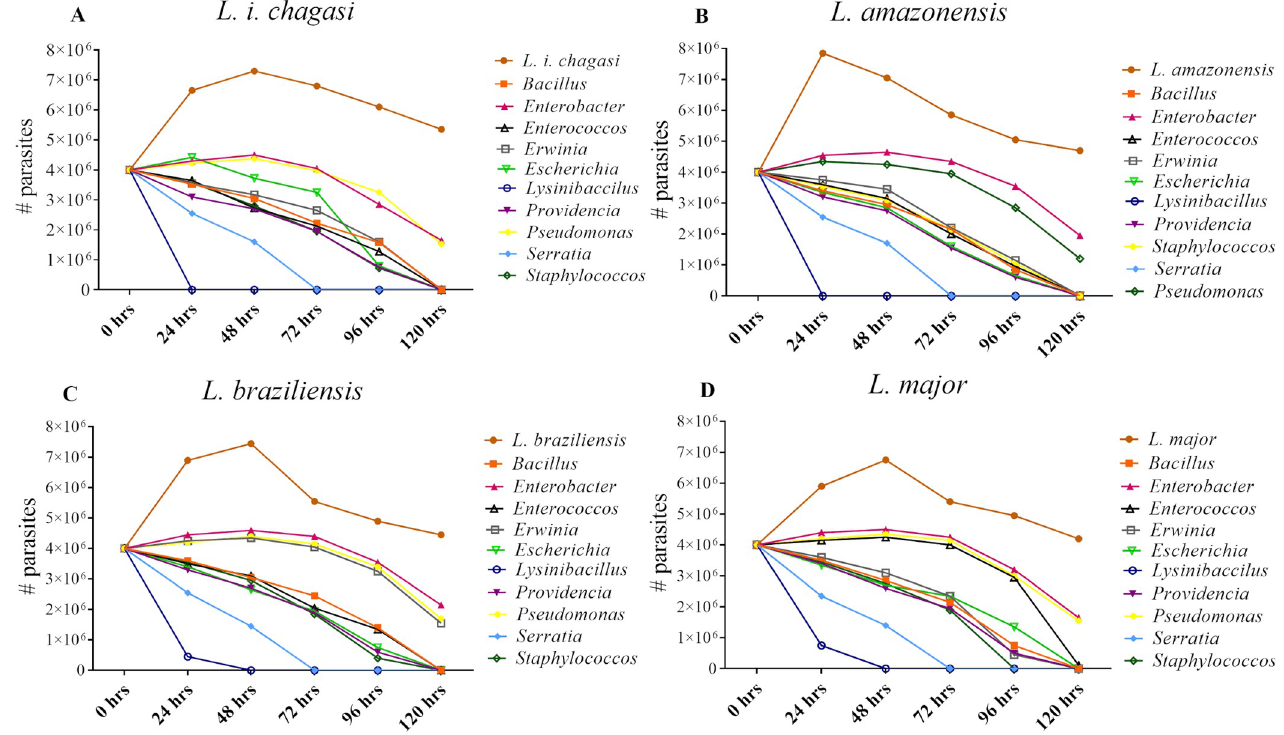
Fig 2. The long term mortality of Leishmania species when co-cultured with native bacteria. Over a 120 hrs. evaluation showing a reduction in parasite growth exerted upon four Leishmania species when co-cultured with ten bacterial genera isolated from Lu . longipalpis . (A) L . i . chagasi , (B) L . amazonensis , (C) L . braziliensis , and (D) L . major